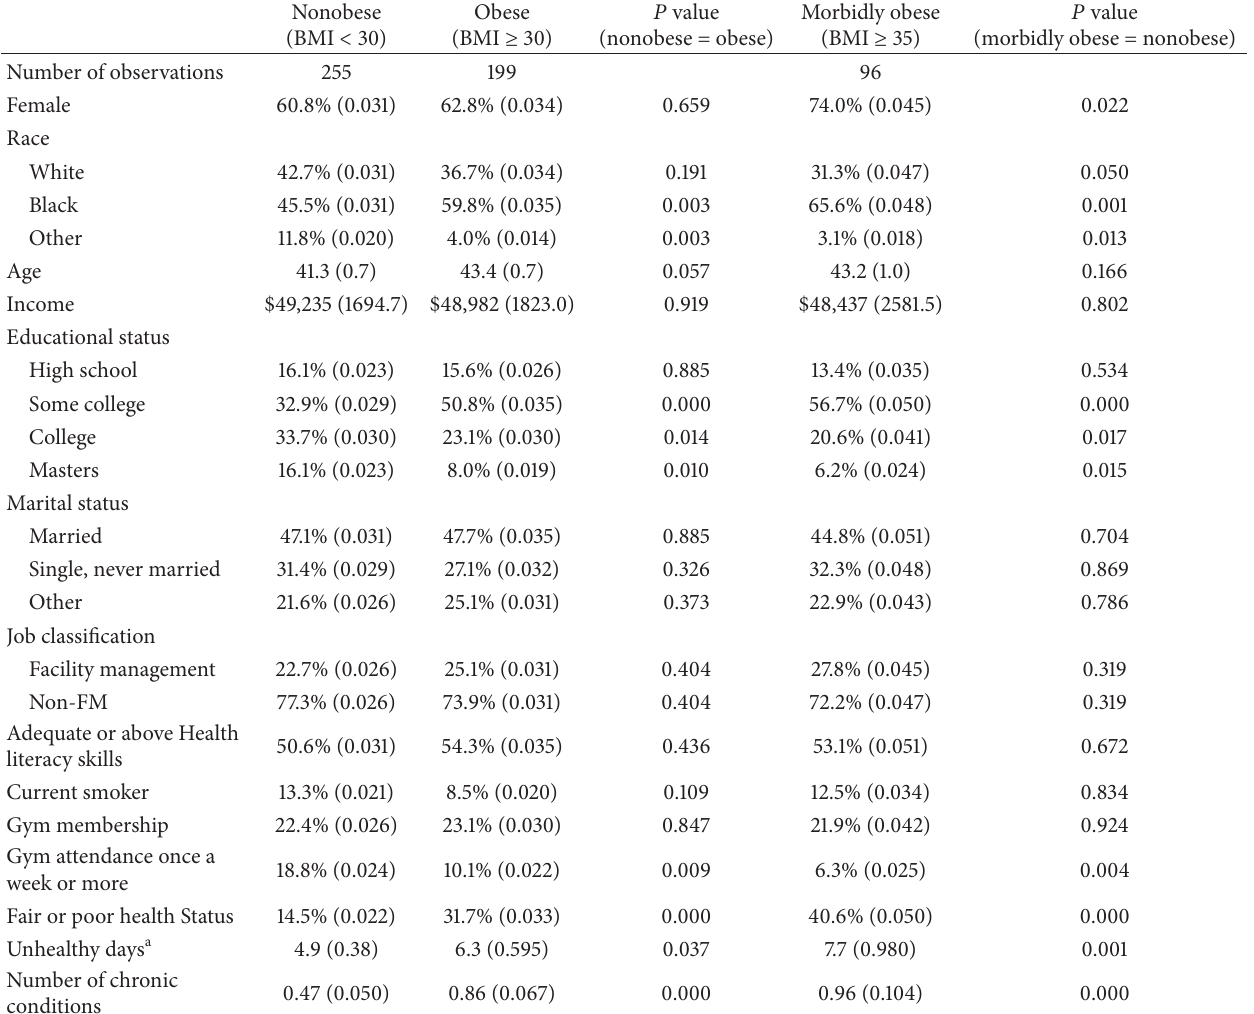
Table 1: Characteristics of study population (means or % { standard errors } ) by obesity